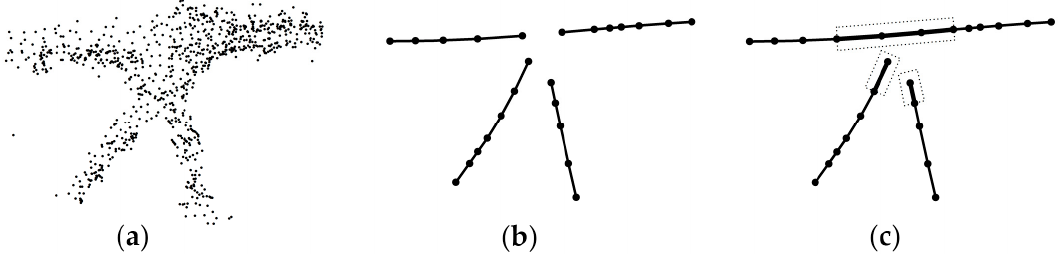
Figure 5. Identifying collinear road segments around the intersection. ( a ) Input GNSS trajectories around the intersection; ( b ) road segments extracted from the input GNSS trajectories; and ( c ) two segments are combined into a single segment, and the other two segments remain unchanged. The black segments represent road segments, and the bold black segments represent the end segments of the road segments.